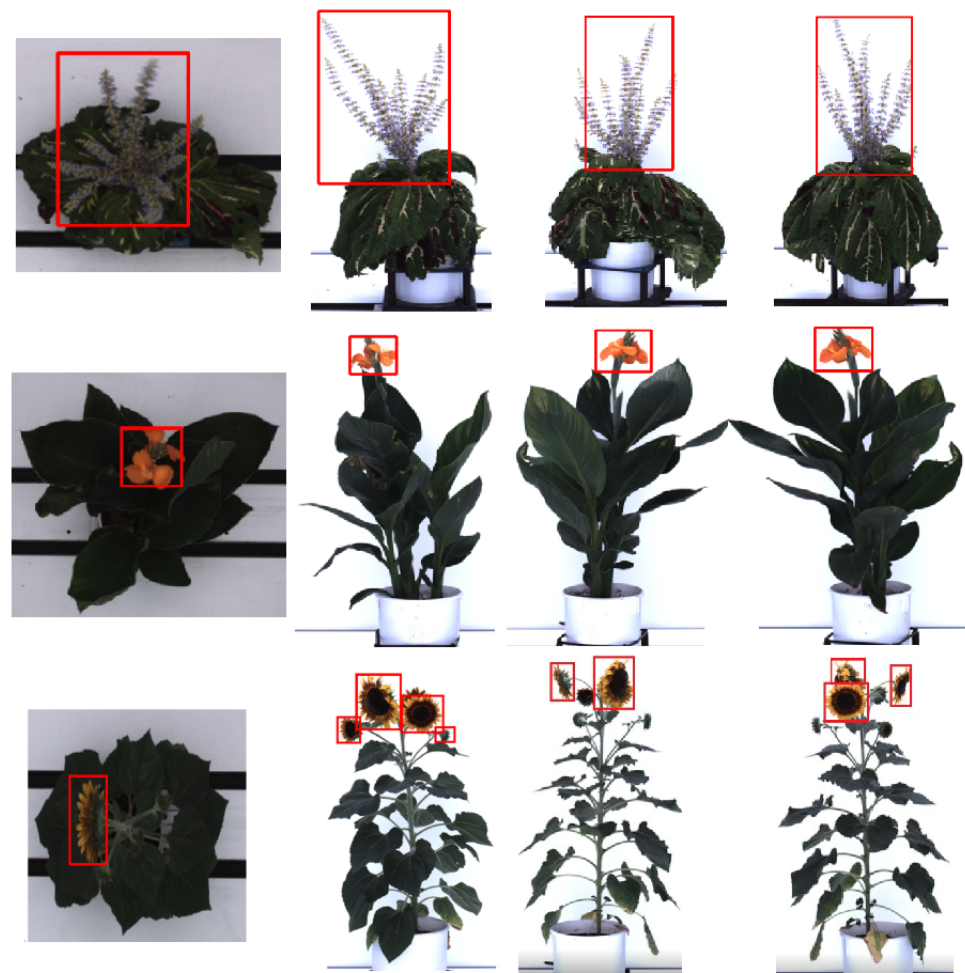
Figure 3. Sample labeled multi-view images from FlowerPheno dataset used for training: Coleus (row-1); Canna (row-2); and Sunflower (row-3). Top-view (column-1); Side-view 0 ◦ (column-2); Side-view 108 ◦ (column-3); Side-view 288 ◦